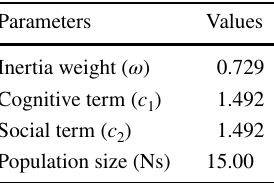
Table 1 Particle swarm algorithm